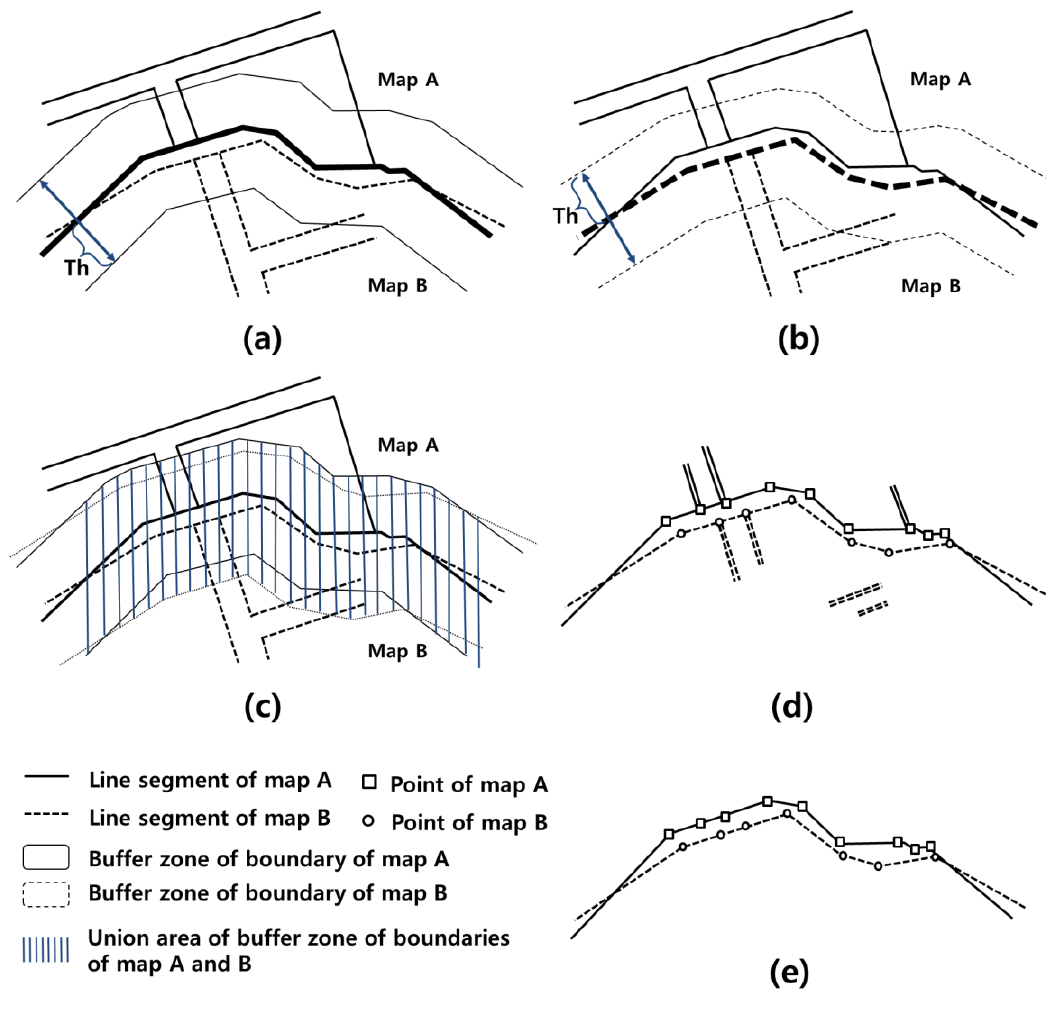
Figure 3. Extraction of point strings from adjacent spatial datasets; ( a ) buffer zone of boundary of map A, ( b ) buffer zone of boundary of map B, ( c ) union area of buffer zones of boundaries of map A and B, ( d ) line segments extracted by union area, ( e ) point strings to be